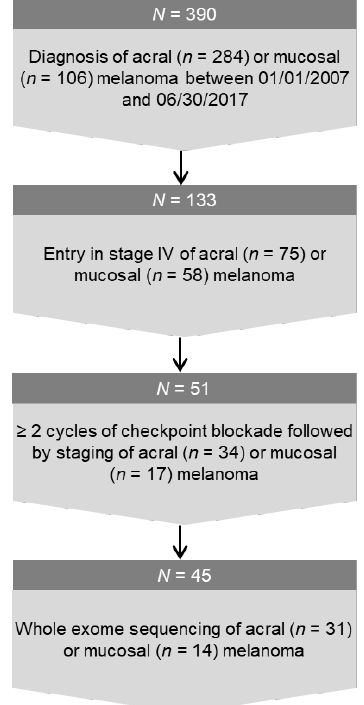
Figure 1. Flowchart of cohort generating.